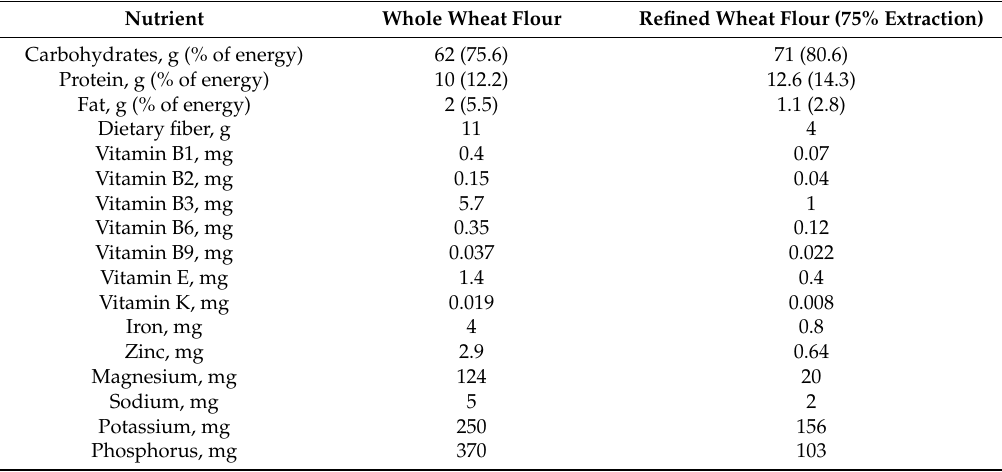
Table 2. Nutritional composition differences between whole and refined wheat flour, per 100 g